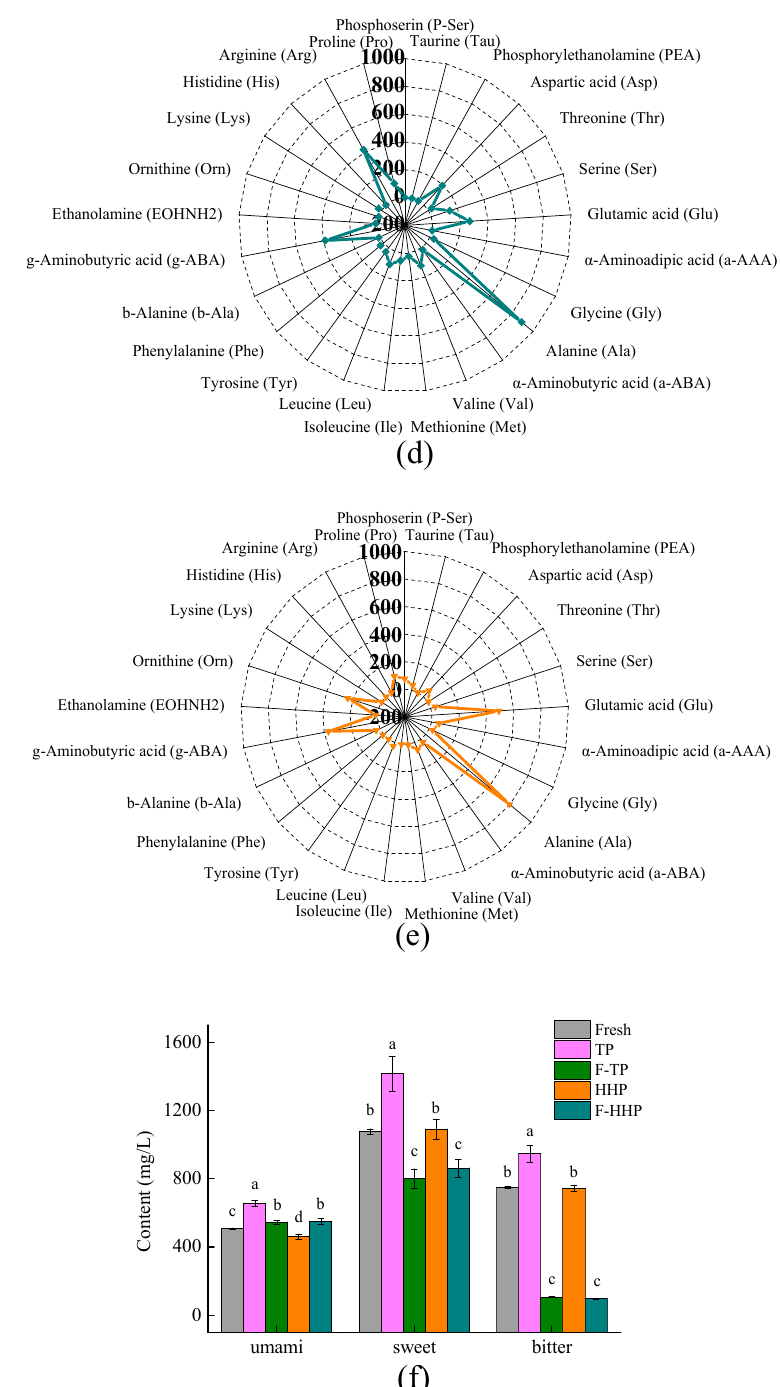
Different letters represented a signi fi cant difference within the same taste characteristic ( p < 0.05). Figure 2. Free amino acid ( FAA ) in di ff erent treated yacon-litchi-longan (YLL) juice. FAA content (mg / L) in the ( a ) fresh juice, ( b ) thermal processing treated YLL juice (TP), ( c ) fermented thermal Figure 2. Free amino acid ( FAA ) in different treated yacon-litchi-longan (YLL) juice. FAA content processing treated YLL juice (F-TP), ( d ) high hydrostatic pressure treated YLL juice (HHP), and ( e ) (mg/L) in the (a) fresh juice, (b) thermal processing treated YLL juice (TP) , (c) fermented thermal fermented high hydrostatic pressure treated YLL juice (F-HHP), ( f ) Total content of FAA with taste processing treated YLL juice (F-TP), (d) high hydrostatic pressure treated YLL juice (HHP), and (e) characteristics in di ff erent treated YLL juice (Di ff erent letters represented a significant di ff erence within fermented high hydrostatic pressure treated YLL juice (F-HHP), (f) Total content of FAA with taste the same taste characteristic ( p < characteristics in different treated YLL juice.